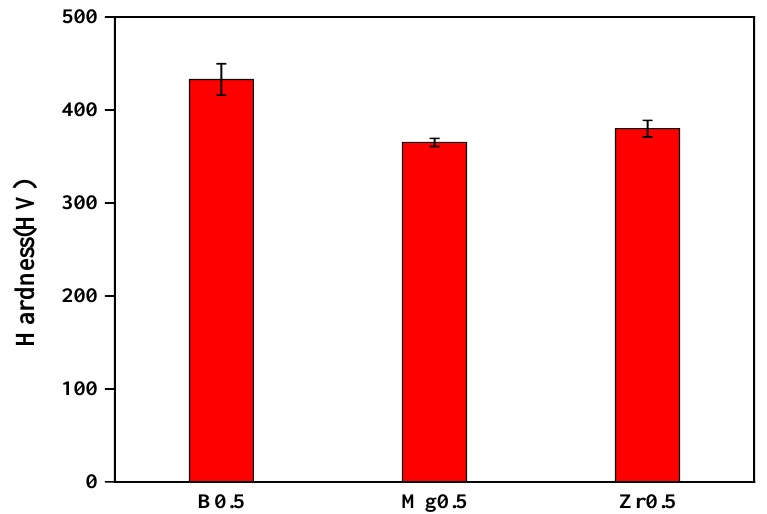
Figure 6. Average hardness values and deviations of the B0.5, Mg0.5, and Zr0.5 HEAs.